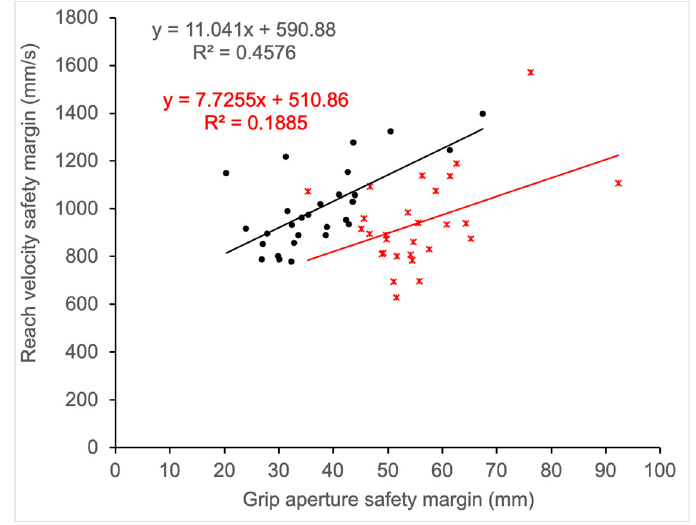
Figure 7. Association between the safety margin for reaching and grasping components of prehension. Individual data points represent the intercept from each participant’s regression analysis relating peak grip aperture and object size (grip aperture safety margin) and reach peak velocity and object distance (reach velocity safety margin). Note that higher safety margin is indicated by higher values on the abscissa and lower values on the ordinate.